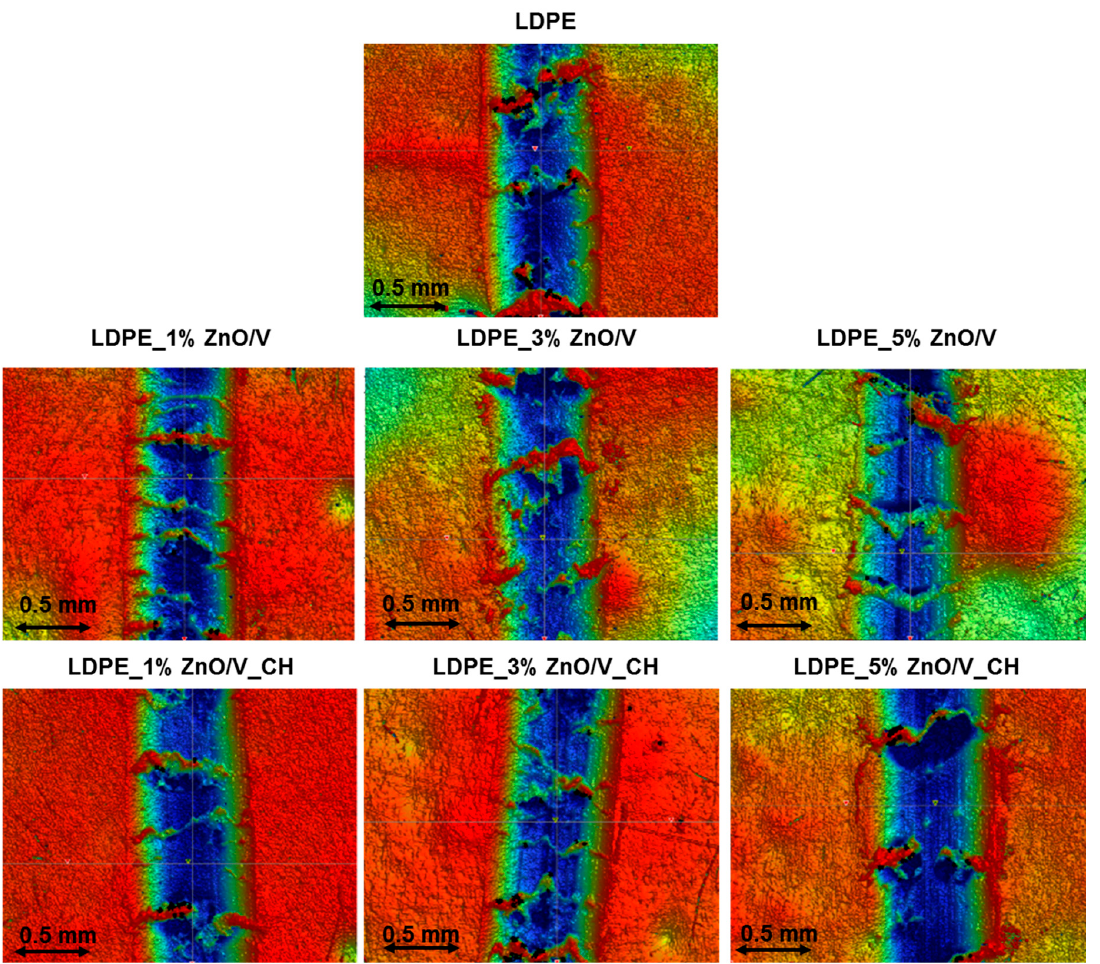
Figure 8. The optical profilometry images against a steel ball after F2N_v5 tests of the natural LDPE surface and LDPE_1% ZnO / V, LDPE_3% ZnO / V, LDPE_5% ZnO / V, LDPE_1% ZnO / V_CH, LDPE_3% ZnO / V_CH and LDPE_5% ZnO / V_CH nanocomposites.